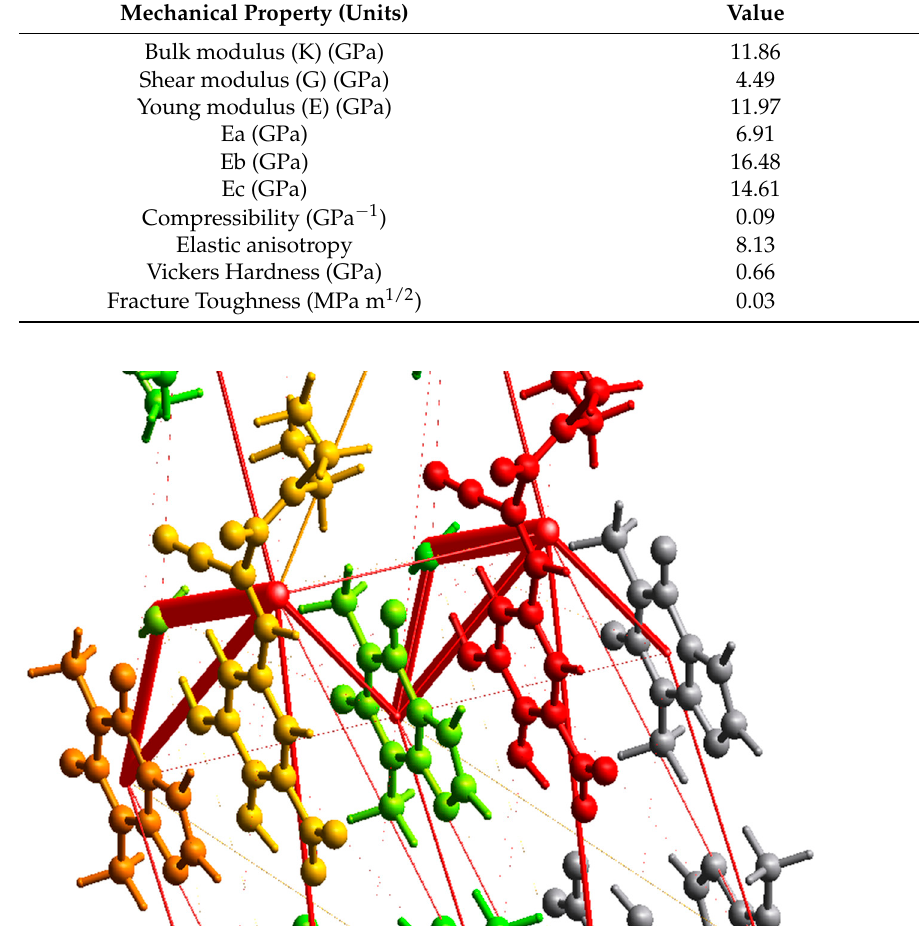
Figure 12. Close-up view of the coulombic term of the lattice energy frameworks.